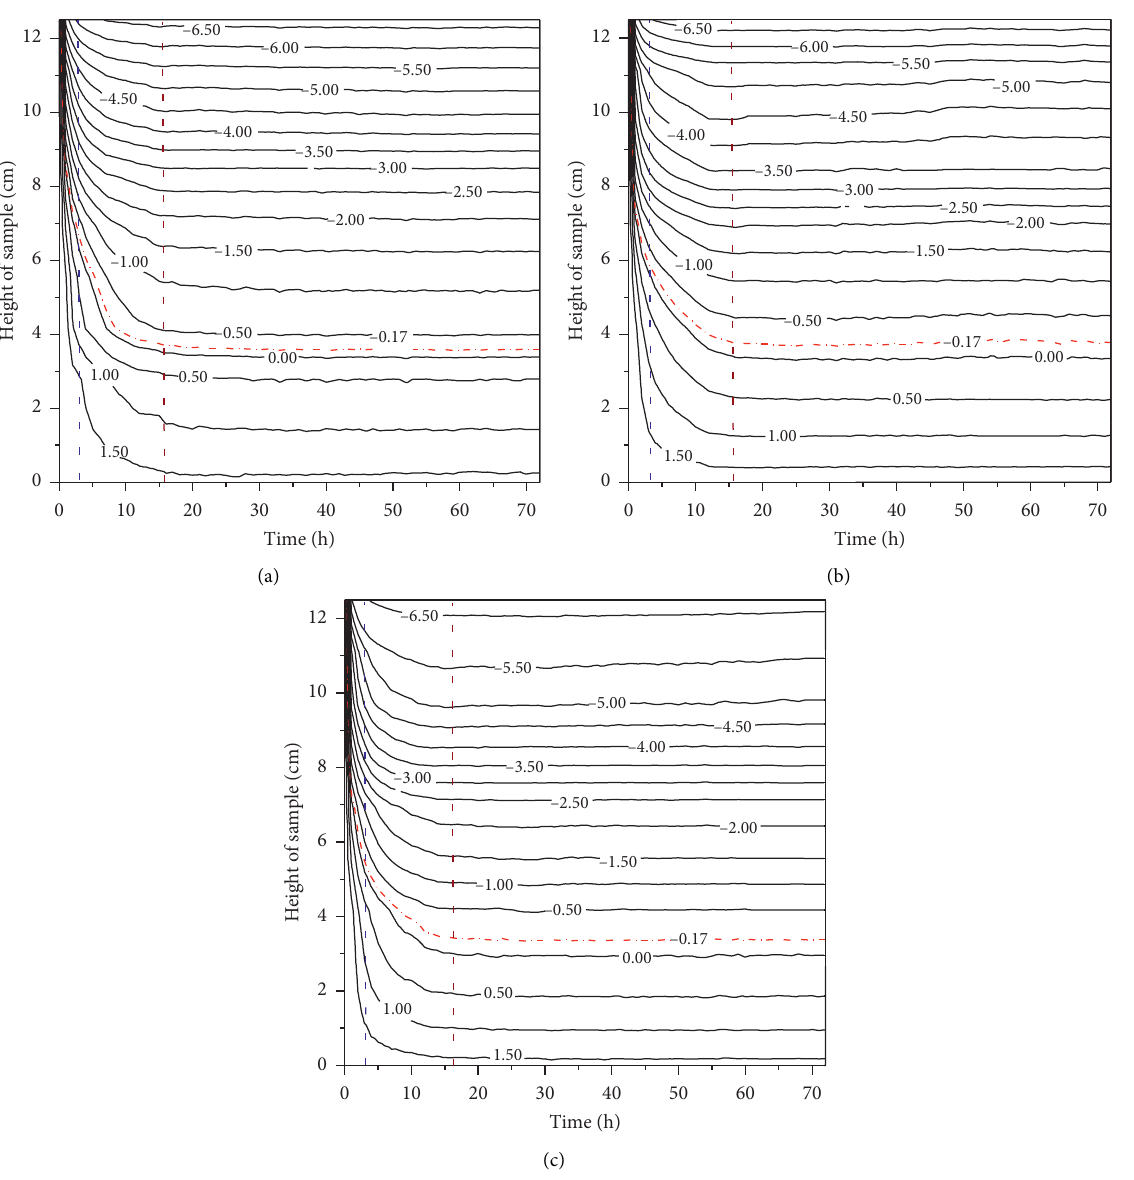
Figure 5: The temperature changes in soil samples with different initial moisture contents. (a) ω � 11%, T (b) ω � 14%, T top �− 7 ° C, and ρ d � 1.75 g ∙ cm − 3 ; (c) ω � 17%, T top �− 7 ° C, and ρ d � 1.75 g ∙ cm − 3